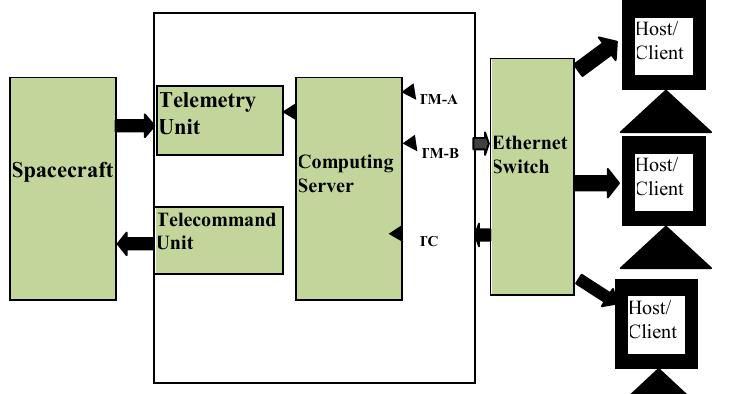
external world through a computing server as shown in figure